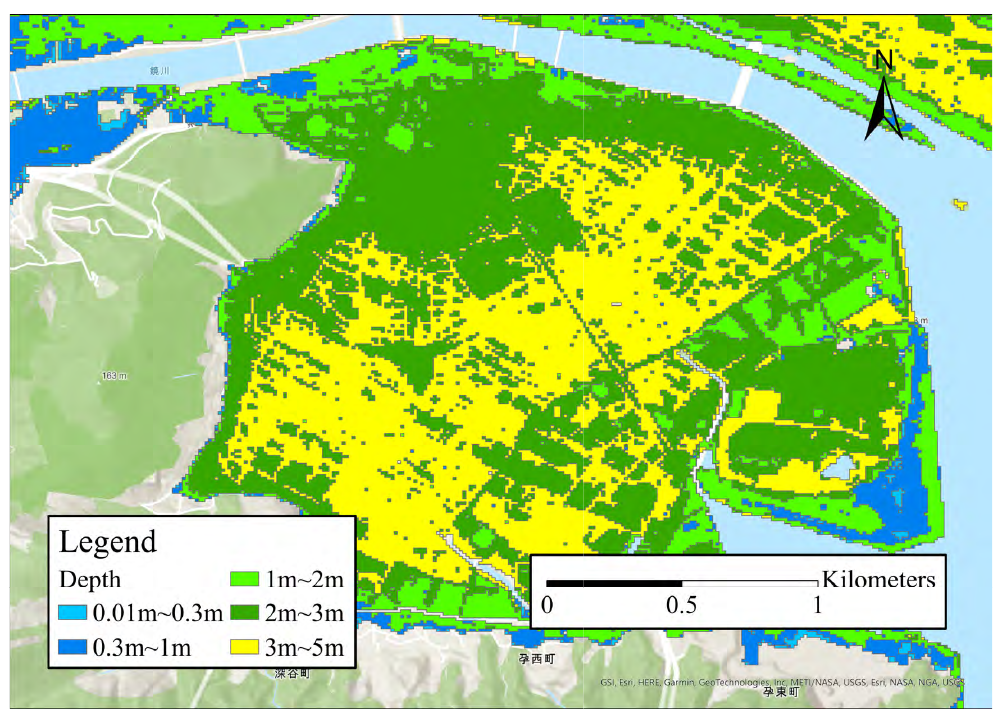
Figure 2. Estimated tsunami inundation depth for the Nankai Trough earthquake in Ushioe district in Kochi City, Kochi Prefecture, Japan. Data from